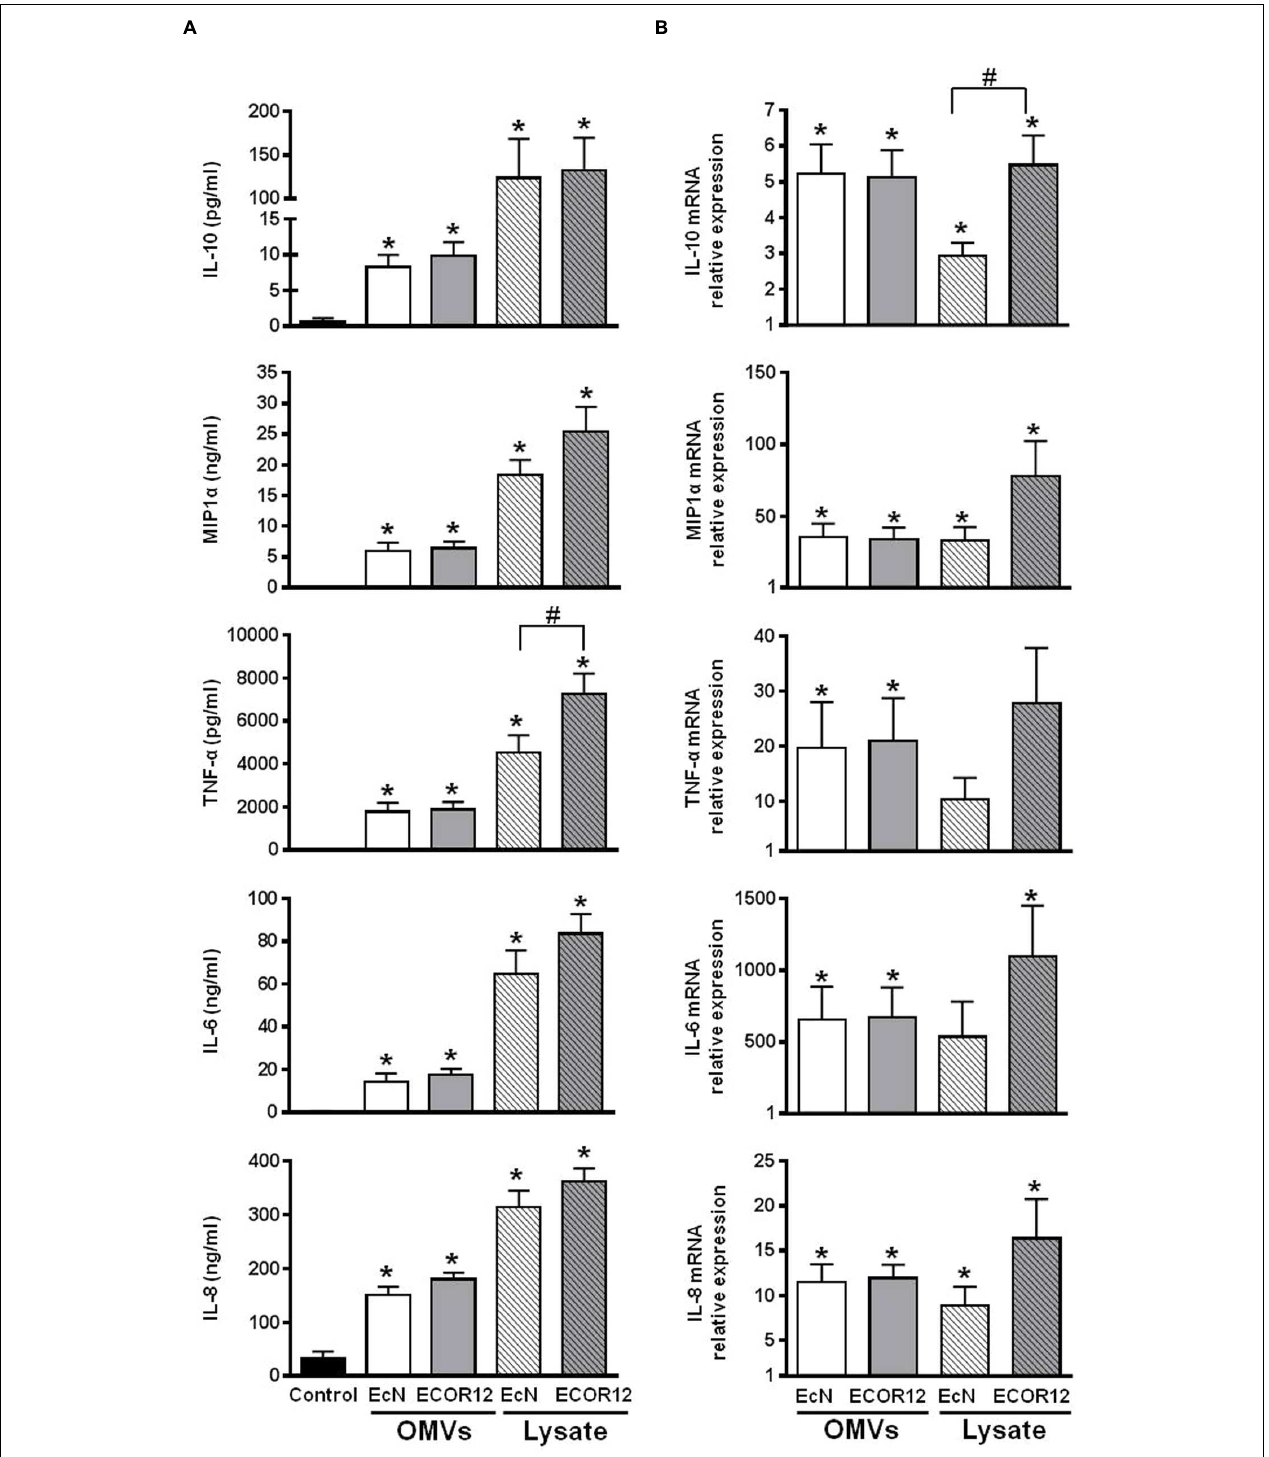
FIGURE 2 | Expression analyses of secreted cytokines and chemokines in PBMCs stimulated with OMVs or bacterial lysates. PBMCs were challenged by addition of OMVs or bacterial lysates from EcN or ECOR12 strains. (A) Cytokine concentration in culture supernatants after 24 h stimulation. Data are expressed as mean ± SEM. (B) Relative gene expression levels in cells after 5 h stimulation. Data are presented as fold-change compared to untreated control cells. Statistical differences were assessed by one-way ANOVA followed by Tukey’s test. ∗ p ≤ 0.05, versus control cells; # p ≤ 0.05, between cells treated with OMVs from EcN or